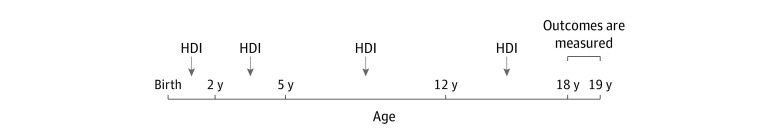
Data Structure for the StudyData are based on a birth cohort from 1987 to 1995. The vertical arrows indicate the age when household dysfunction item (HDI) exposure may occur.